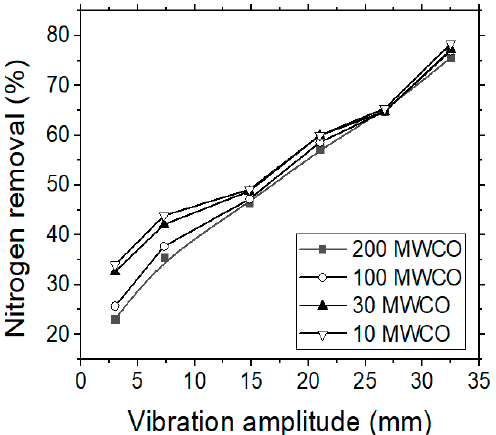
Figure 5. VSEP treatment of simulated tannery wastewaters; the effect of vibration amplitude on the N total removal (%) rate by applying four different UF membranes.